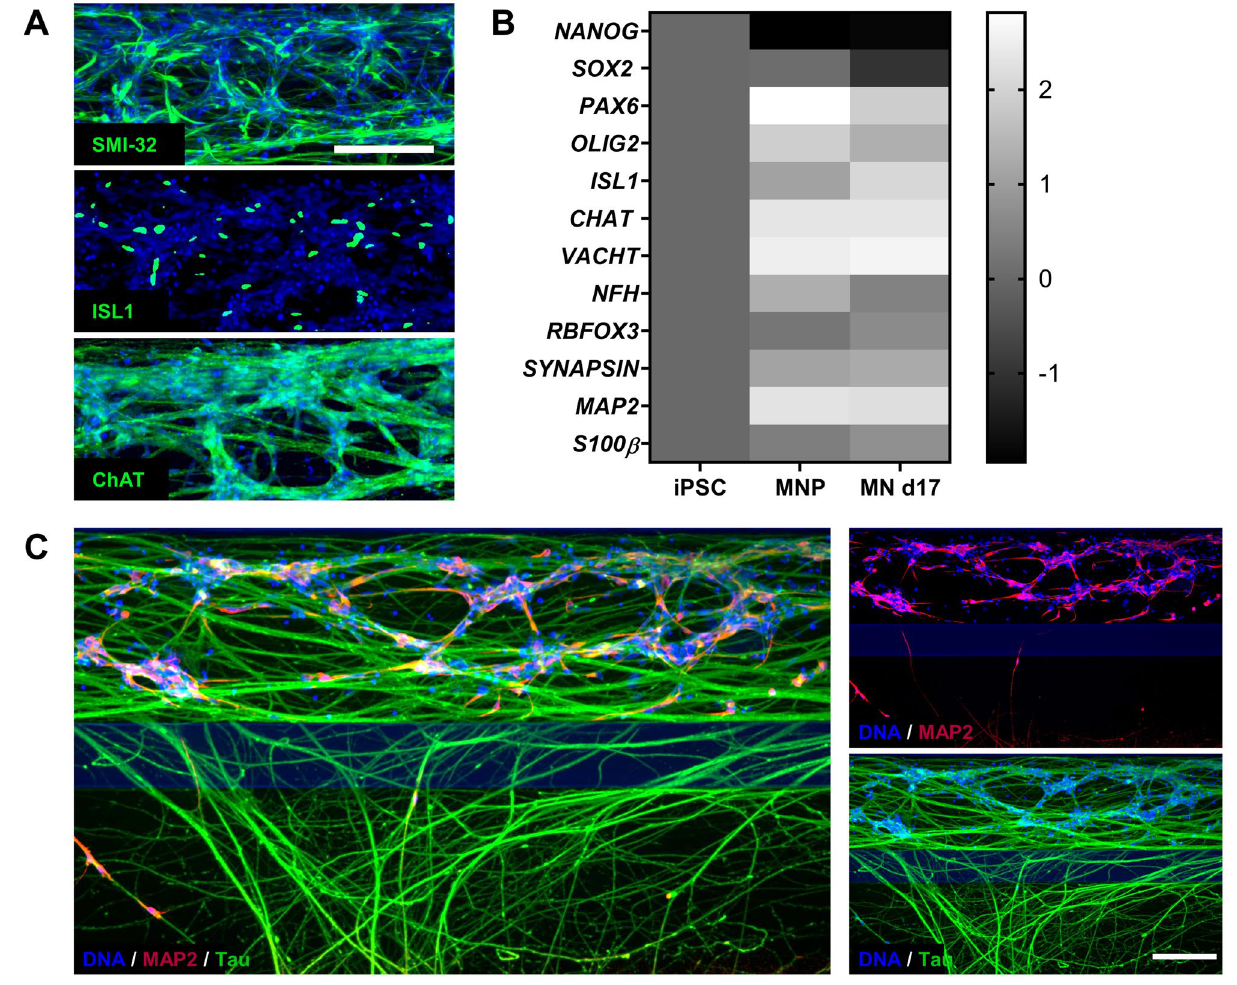
Figure 2. Progenitors differentiate into motor neurons and extend their axons into an adjacent gel lane. ( A ) MNPs were differentiated in the OrganoPlate for 17 days and immunostained for motor neuron markers SMI- 32, ISL1, and CHAT. Maximum projection images of neuronal networks in the top lane are shown, the scale bar is 200 µm. ( B ) mRNA expression levels of induced pluripotent stem cells (iPSC), motor neuron progenitors (MNP) and motor neurons differentiated for 17 days (MN d17) in the OrganoPlate. Expression of markers of neural stem cells ( NANOG , SOX2 , PAX6 ), motor neuron progenitors ( OLIG2 ), motor neurons ( ISL1 , CHAT , RBFOX3 , VACHT , NFH ), mature neurons (SYN1/ SYNAPSIN , MAP2 ) and glial cells ( S100 β) was evaluated. Heatmap shows fold-change values as compared to expression in iPSCs, and the graphic representation was created using GraphPad Prism, version 8.3.1 (https ://www.graph pad.com/scien tific -softw are/prism /). ( C ) Motor neurons (day 17) were immunostained for dendritic marker MAP2 (red) and axonal marker TAU (green). Neurites protruding into the middle lane are mostly TAU-positive and MAP2-negative, indicating a predominantly axonal nature. Maximum projection images, the scale bar is 200